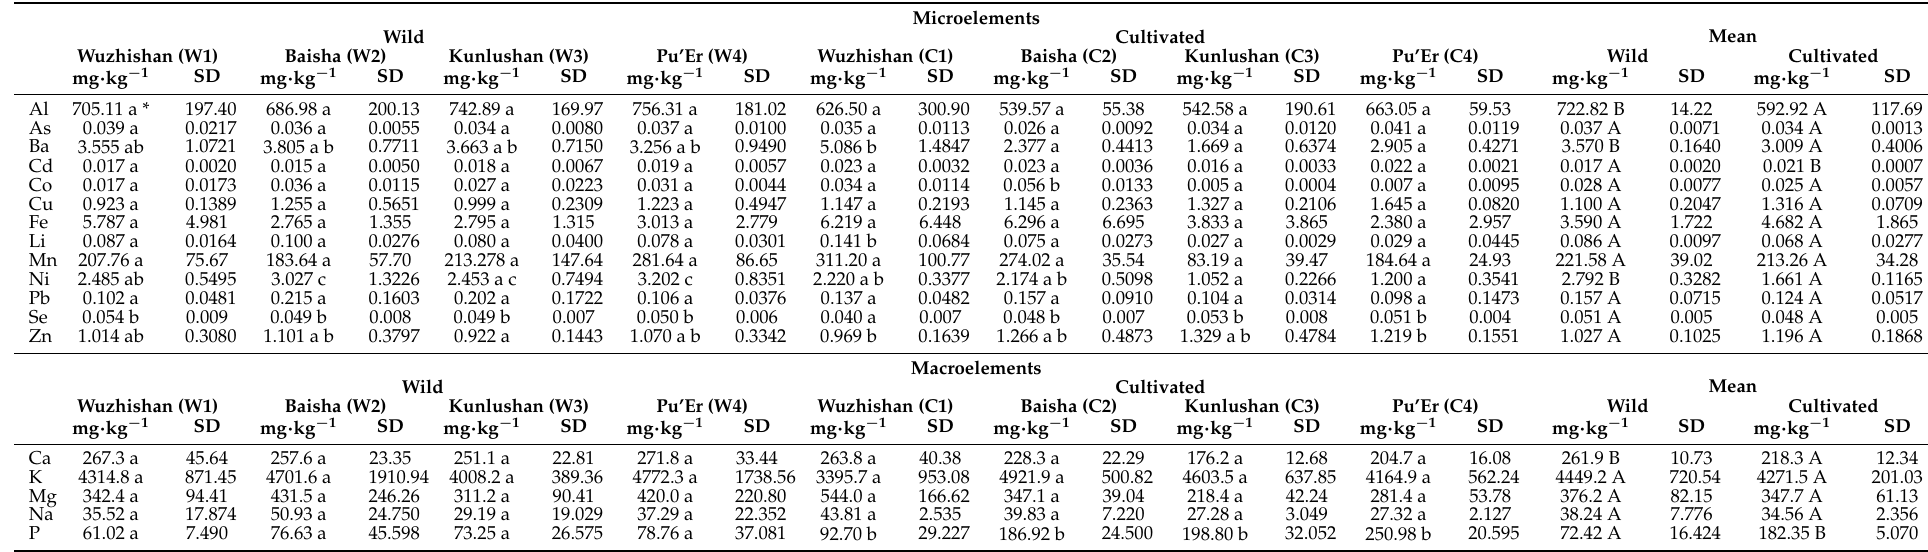
Table 3. Mean concentration of for macro- and microelements in tea infusions (mg · kg − 1